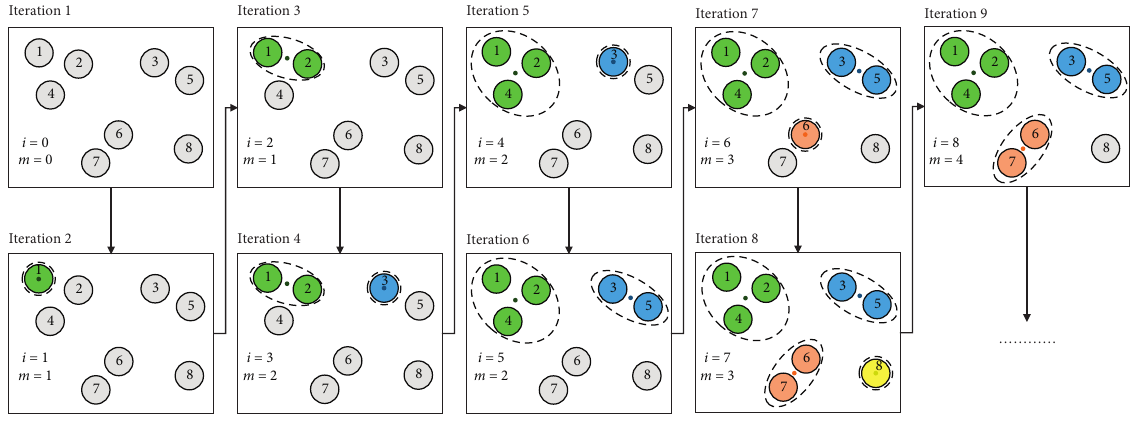
Figure 2: Iterative procedure of the distance-based clustering algorithm.